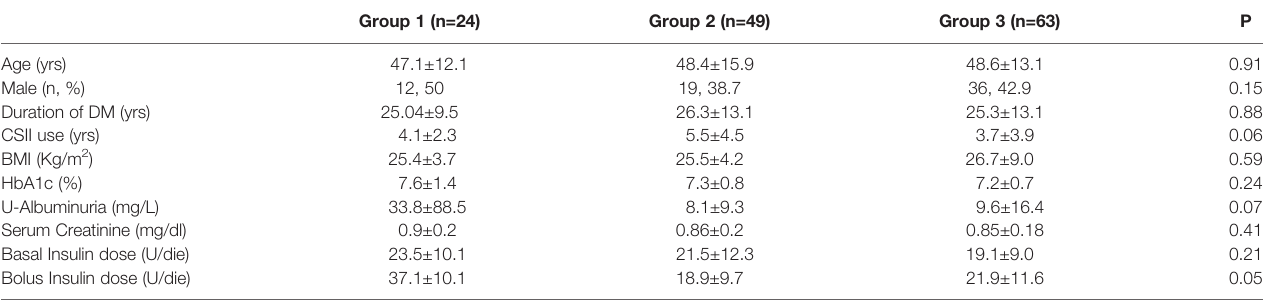
TABLE 2 | Patients